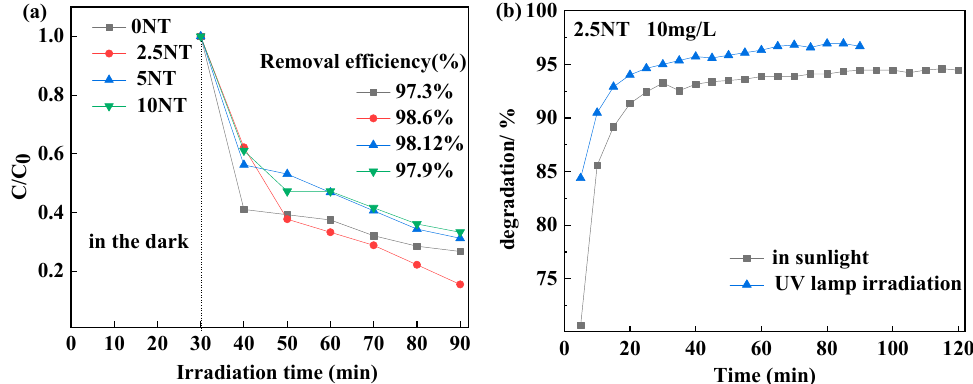
Figure 9. Photocatalytic photodegradation behaviors. ( a ) All of samples, UV radiation; ( b ) 2.5TNT, UV and visible light radiation.